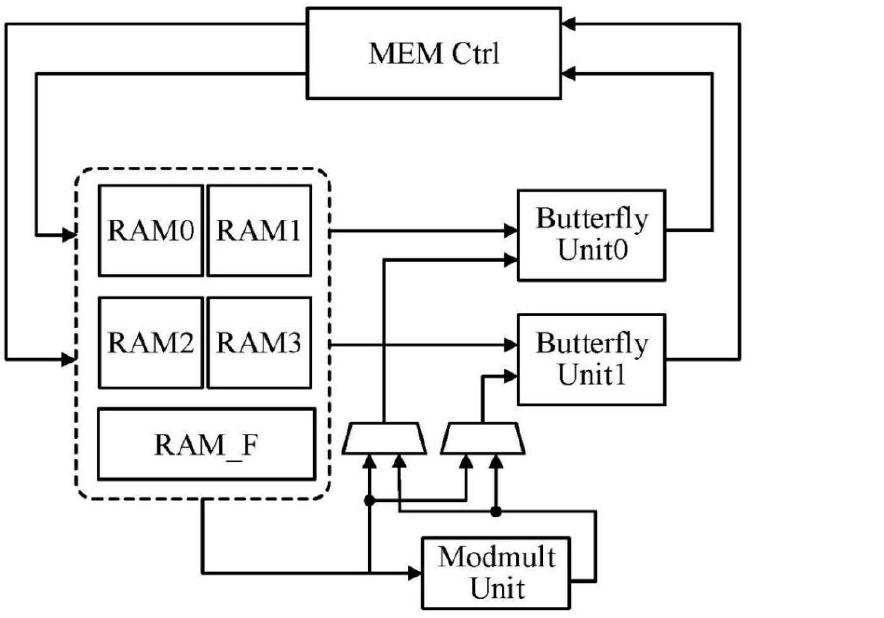
Figure 3. H-NTT module hardware